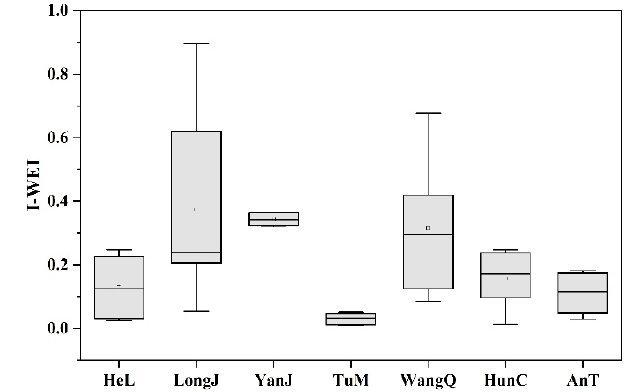
Figure 11. Comparison of industrial water use efficiency in the TRB regions.